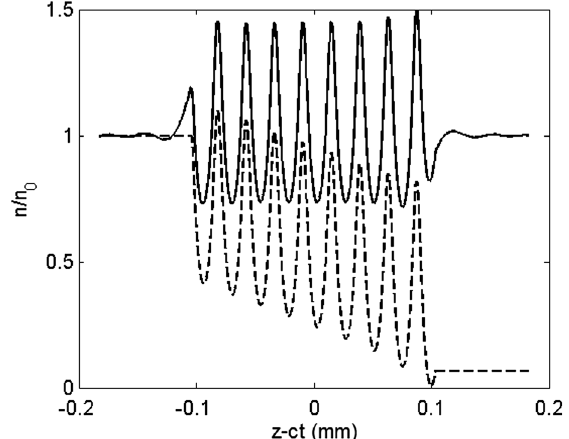
FIG. 3. Comparison of integration results using designed filter (solid line) and cumulative sum (dashed line).